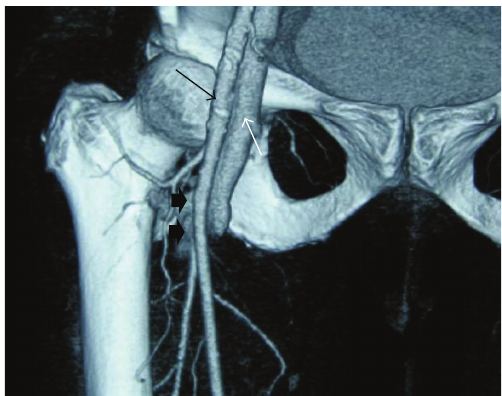
Figure 2: Two discrete arteriovenous fistulas are exposed; the first one (white arrow head on the left side) is between deep femoral artery (black arrow) and femoral vein (white arrow), and the other one (white arrow head on the right side) is between superficial femoral artery (black arrow head) and femoral